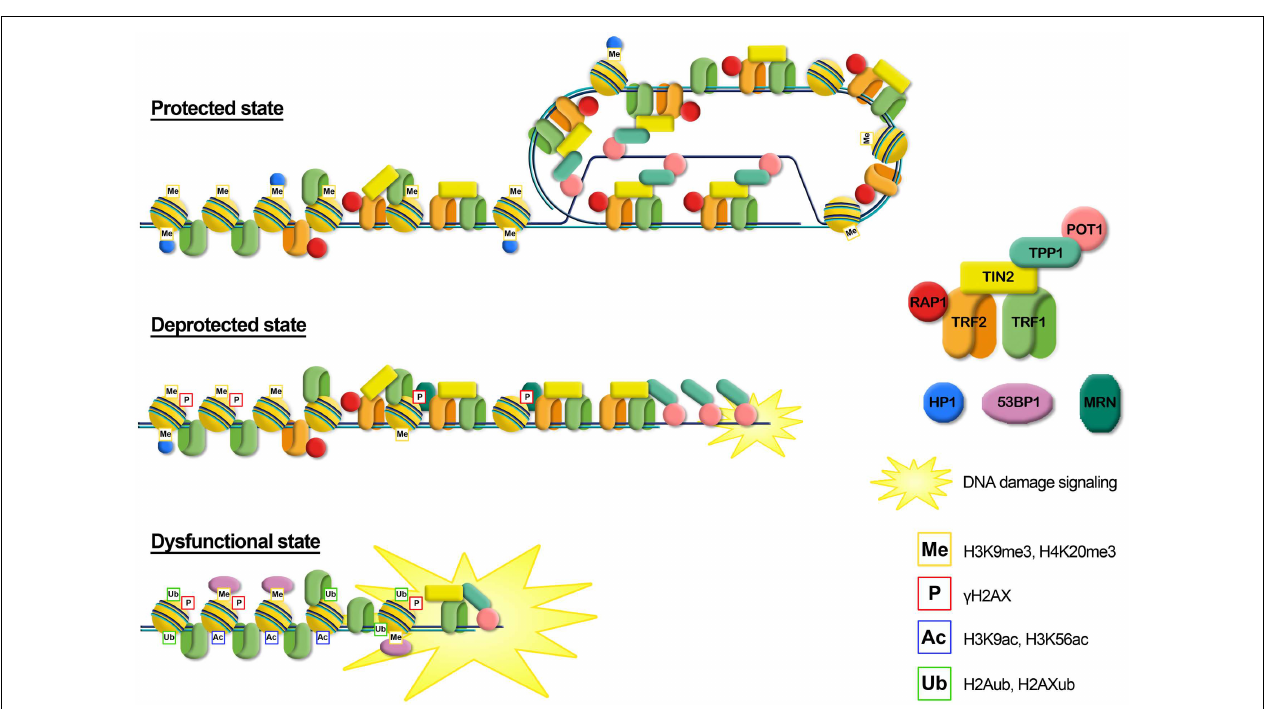
damage, signaled by phosphorylation of H2AX, but retain enough shelterin proteins (mainlyTRF2) to prevent NHEJ and thus telomeric fusion. DNA damage signaling leads to replicative senescence. Dysfunctional state : if growth arrest checkpoint is inactivated, telomeres continue to shorten leading to a fully uncapped form, deriving from the depletion of shelterin proteins such asTRF2 or POT1.Telomere dysfunctions are signaled by phosphorylation of H2AX and the ubiquitylation of H2A and H2AX. Telomeres are not protected from the DNA damage response machinery, giving rise to extensive telomere